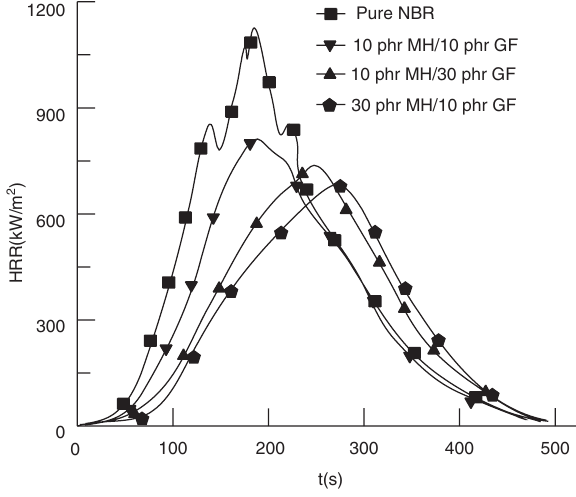
Figure 7 PHRR curves for the nano MH/GF/NBR composite material with different MH/GF fraction